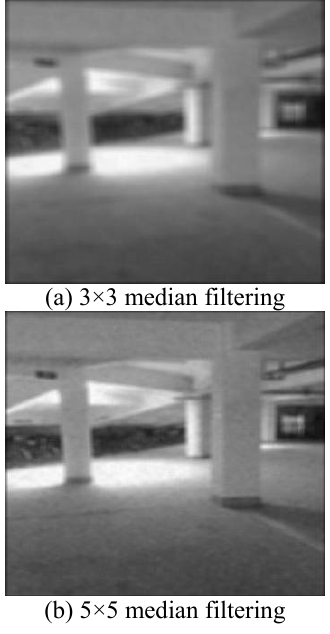
Figure 3 images after median